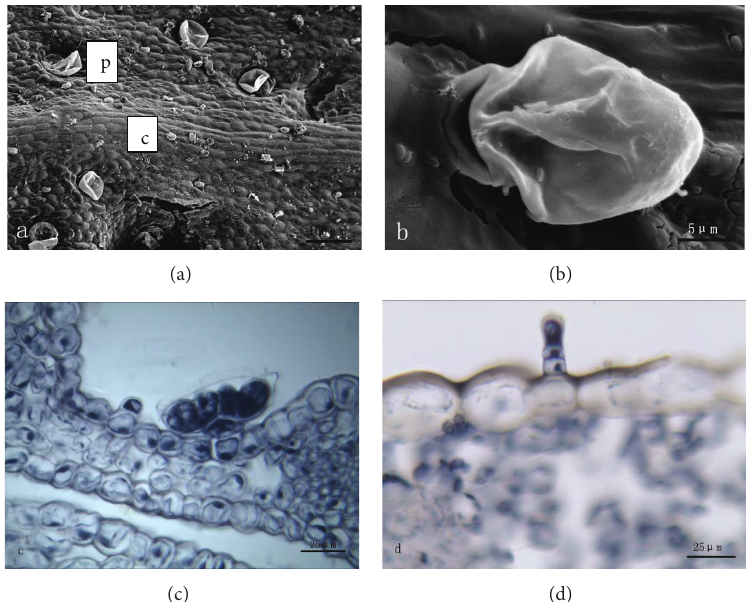
Figure 4: ((a), (b)) SEM micrographs showing the morphology of glandular trichomes on outer side of calyx of T. quinquecostatus. (a) Peltate trichomes (p) and capitate trichomes (c). (b) A capitate trichome. ((c), (d)) Transverse sections of T. quinquecostatus calyx. (c) A peltate trichome. (d) A capitate trichome.